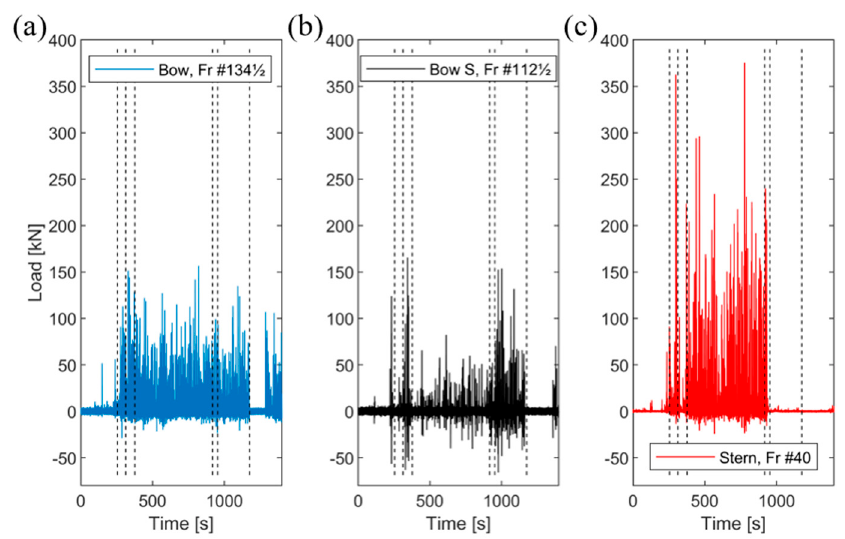
Figure 9. Measured ice-induced loads at ( a ) bow, ( b ) bow shoulder, and ( c ) stern shoulder during tests BC5, T4_1, and T4_2.